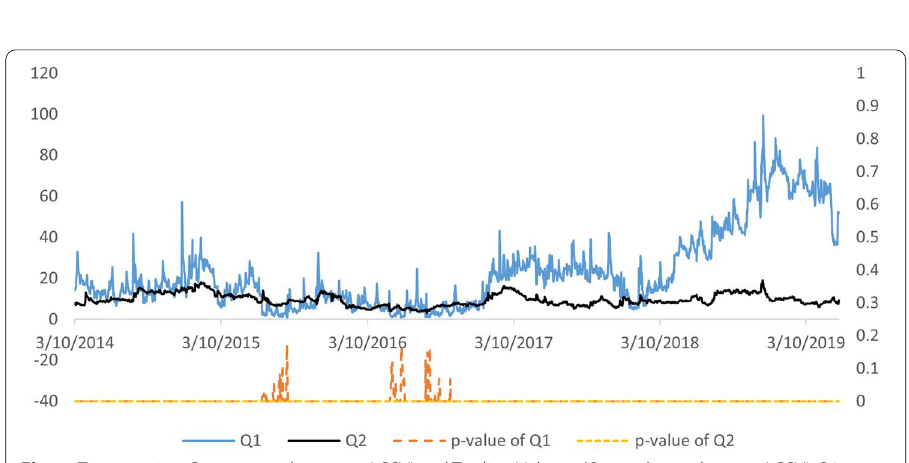
Fig. 7 Time-varying Granger test between AGSVI and Trading Volume (Q1: trading volume-> AGSVI; Q2: AGSVI- > trading